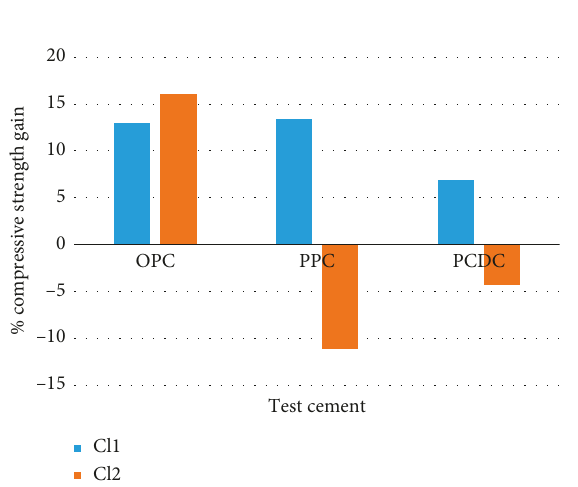
Figure 24: pH measurements in sea water.